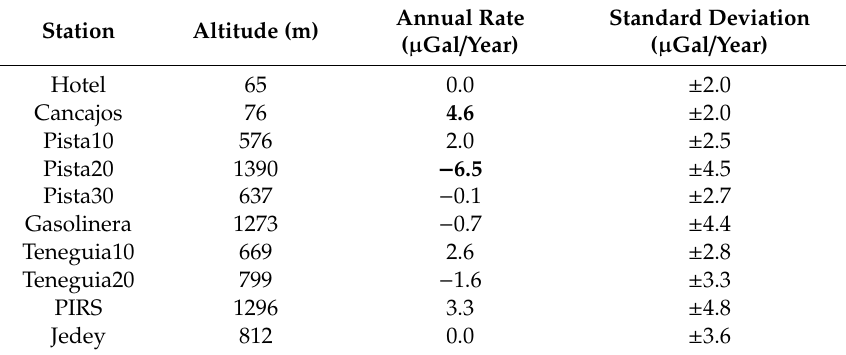
Table 2. Adjusted temporal gravity rates for the 12 gravity stations.